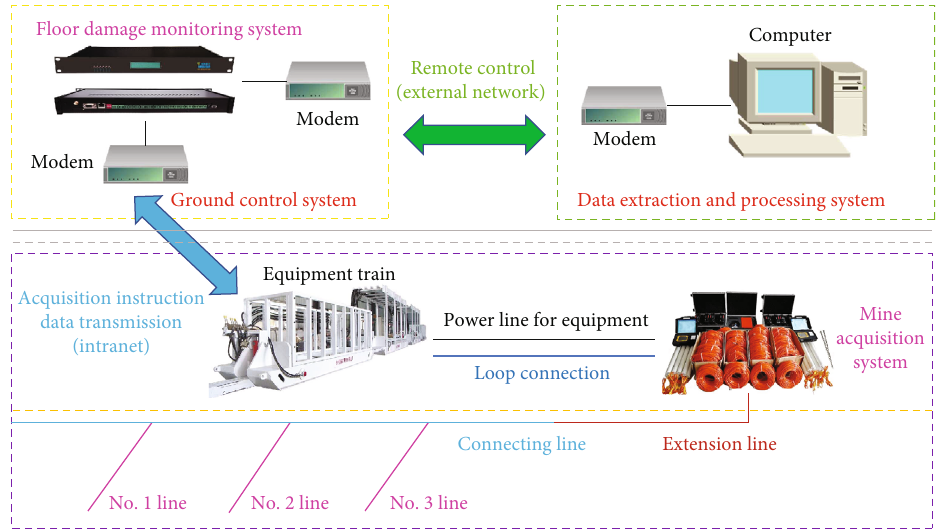
Figure 4: Schematic diagram of data acquisition